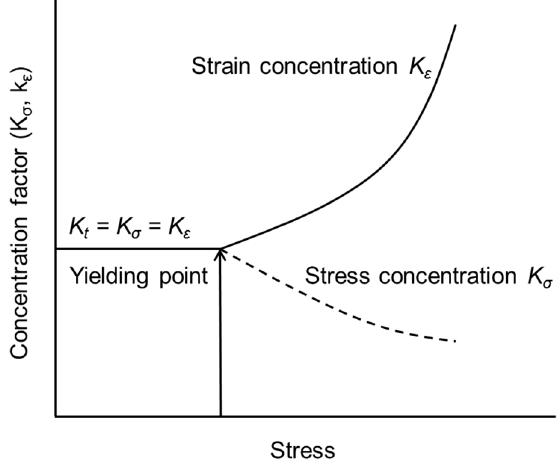
Figure 1. Schematic of the cycle stress–strain curve obtained by hysteresis loop.